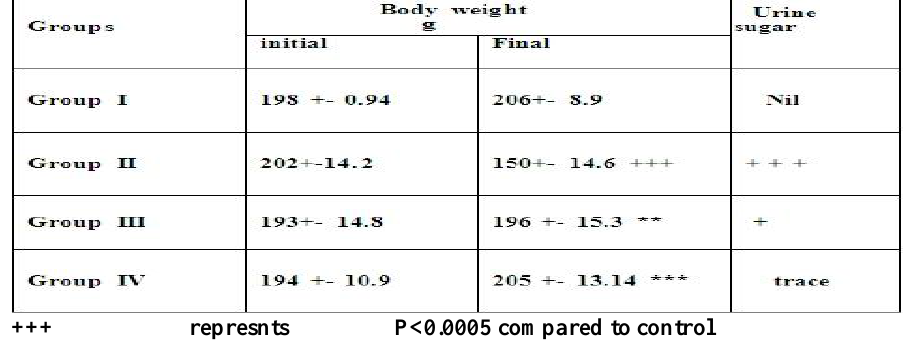
Table-2: Changes in the body weight, and glucose renal reabsorption in control and Experimental